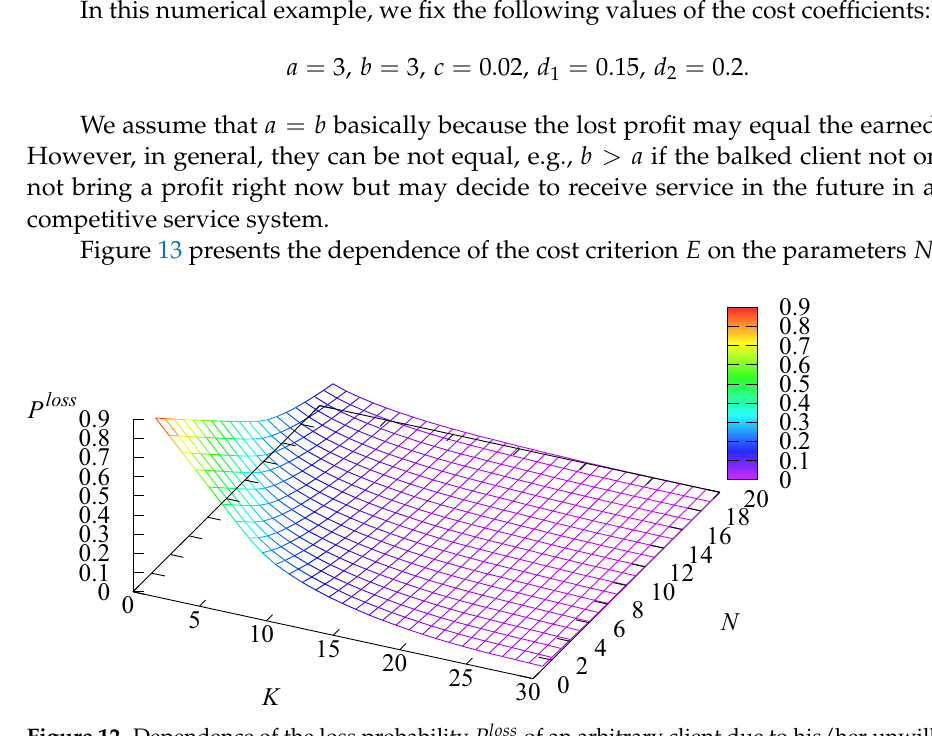
Figure 12. Dependence of the loss probability P loss of an arbitrary client due to his/her unwillingness to join the system on the parameters N and K .